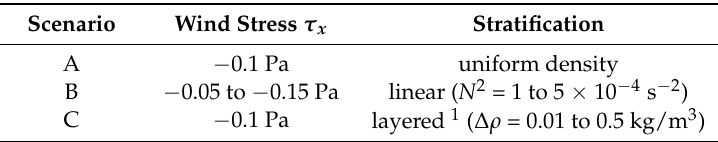
Table 1. Configuration of experiments discussed in the